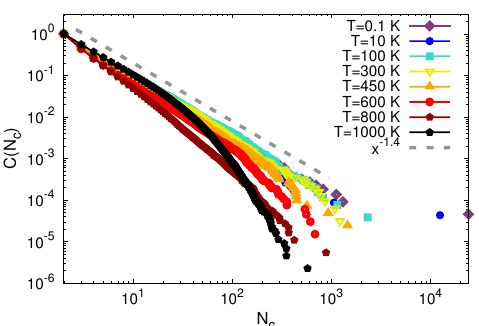
Figure 9. Complementary cumulative distributions C ( N c ) at different temperatures calculated at maximum indentation depth 70 Å. The gray dashed line corresponds to a power law with exponent − 1.4.